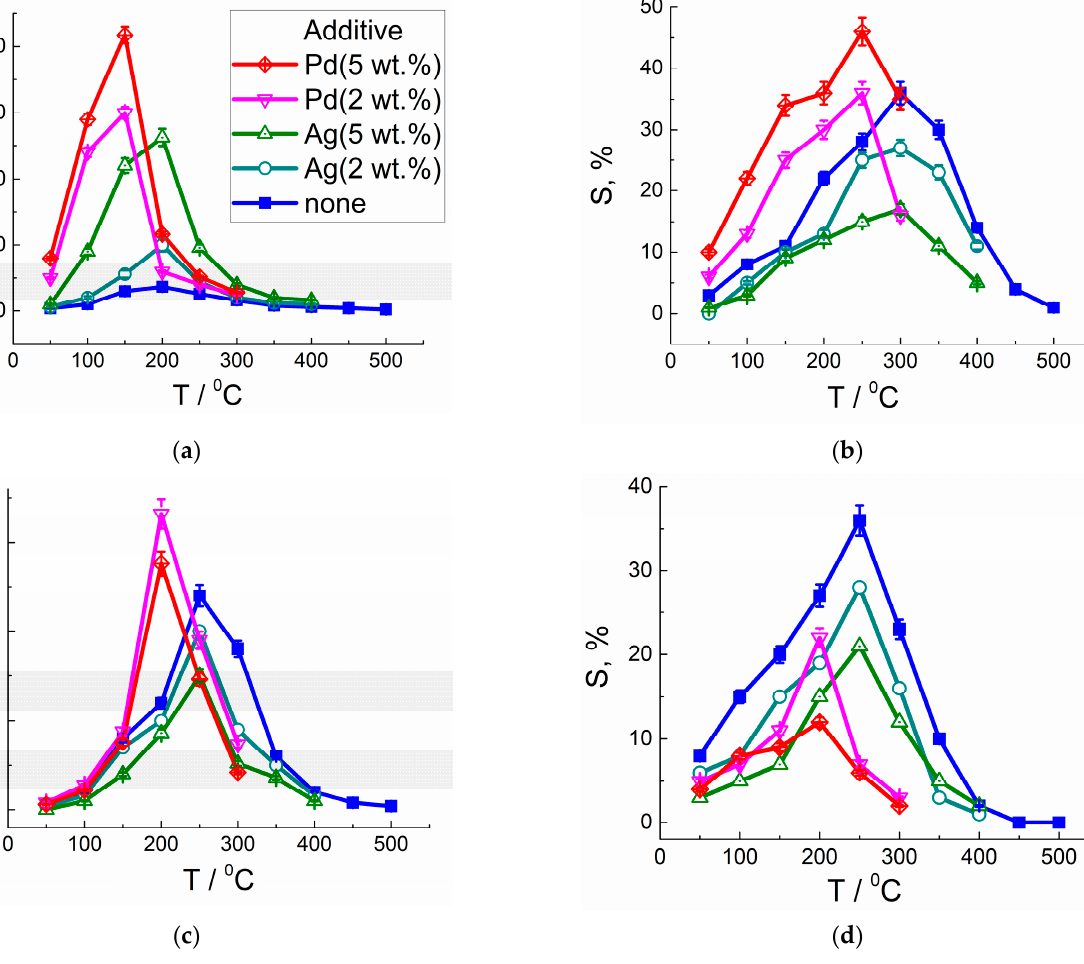
Figure 7. Temperature plots of sensor signals of pristine and Ag- or Pd-modified LaFeO 3 to 20 ppm CO ( a ), 20 ppm NH 3 ( b ), 2 ppm H 2 S ( c ) and 1 ppm NO 2 ( d ). CO ( a ), 20 ppm NH 3 ( b ), 2 ppm H 2 S ( c ) and 1 ppm NO 2 ( d